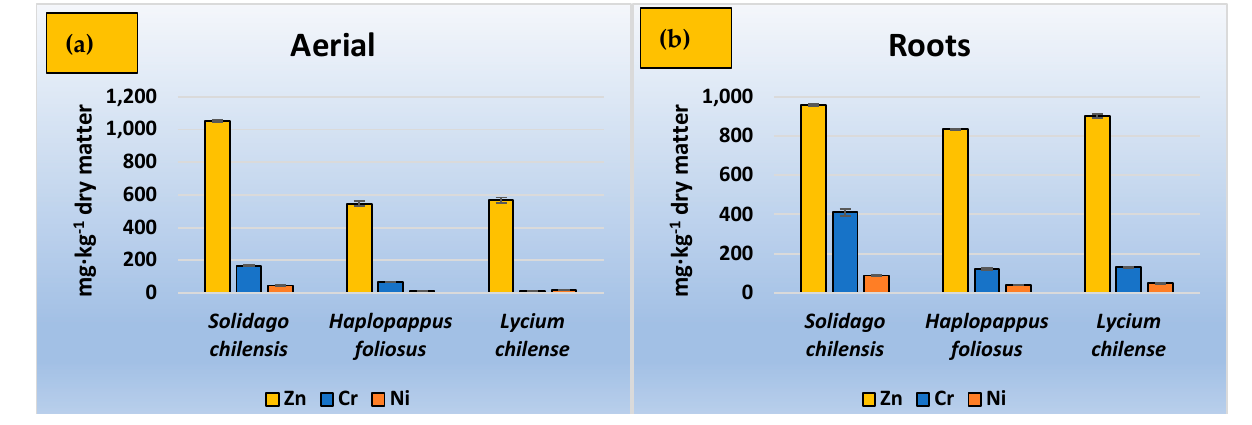
Figure 2. The initial and final concentration of heavy metals. ( a ) Aerial parts, ( b ) roots.